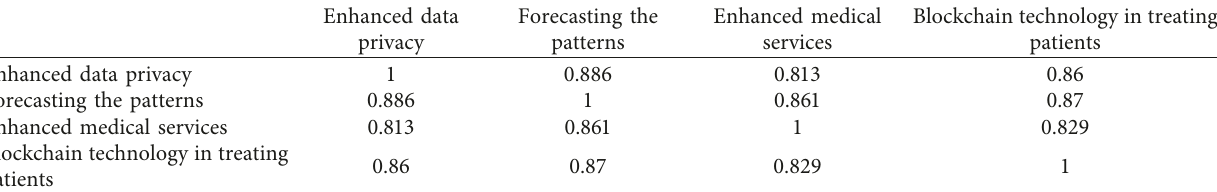
Table 3: Correlation.